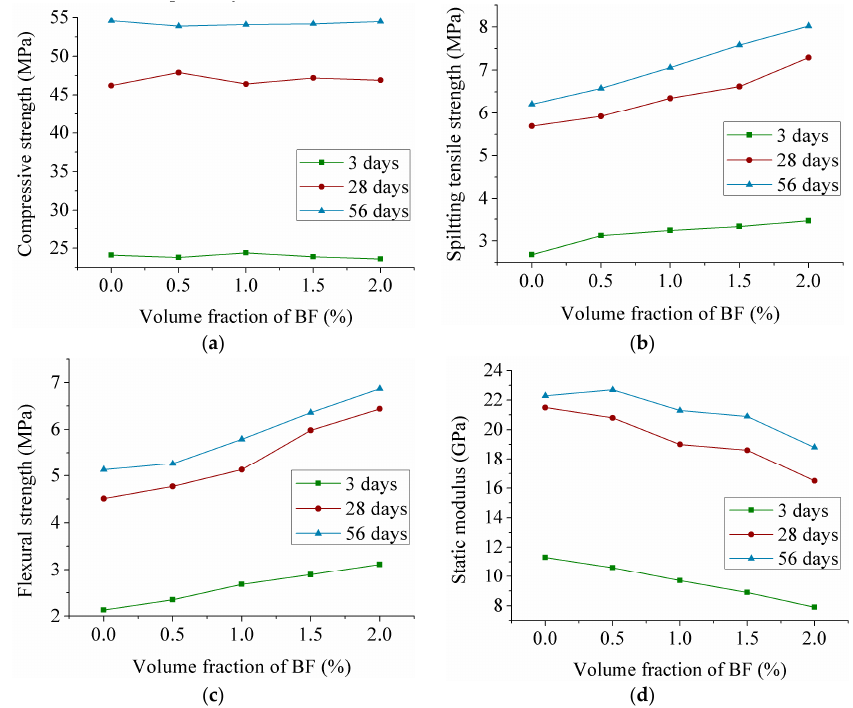
Figure 1. Mechanical properties of ECC for different volume fraction of BF. ( a ) Effect of the volume fraction of BF on the compressive strength; ( b ) Effect of the volume fraction of BF on the splitting tensile strength; ( c ) Effect of the volume fraction of BF on the flexural strength; ( d ) Effect of the volume fraction of BF on the static modulus.